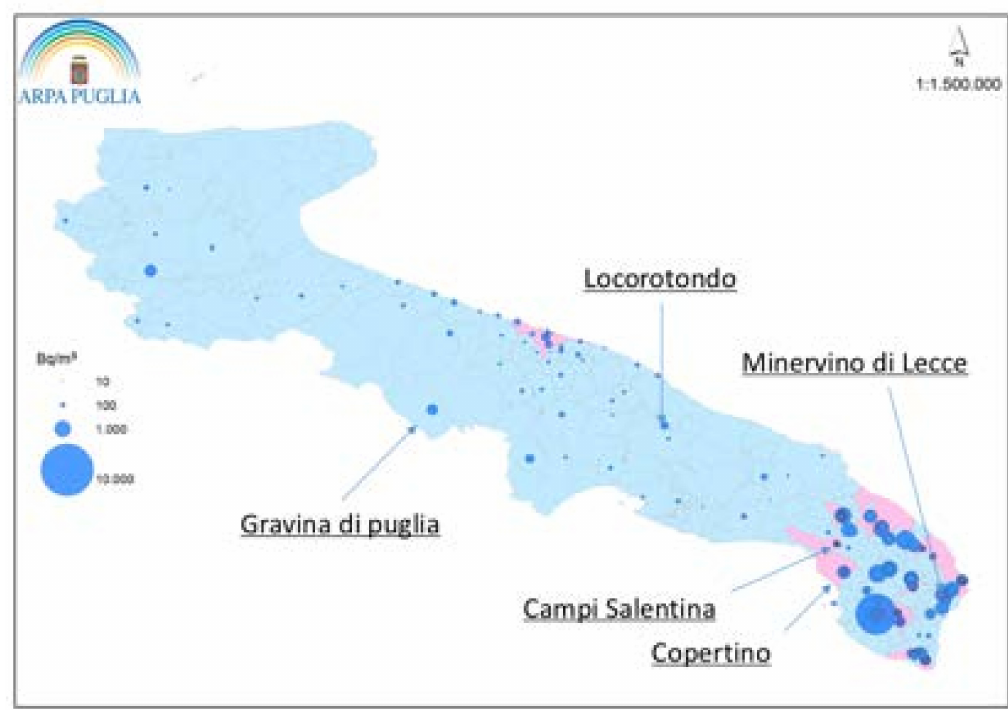
Figure 4. Annual Average concentration of Radon in Apulia region. Notes: In the map, blue circles represent the housing, schools, and workplaces in which ARPA Puglia made the measurements of the concentration of radon. The diameter of each circle is proportional to the average annual concentration measured. The municipalities for which data from at least seven in-house measurements are available and are highlighted in pink. This agency highlights on the basis of the experience gained in the field and especially of what was reported in the literature, that the only safe method to determine the concentration of radon gas inside a closed environment, independently of the results of the campaigns of previously measurements carried out in the same region, same province, the same municipality, even as an adjoining palace, is the direct measure. It was shown that adjacent buildings, with identical constructive characteristics, can have different radon concentrations. Therefore, to evaluate the concentration of radon in a closed environment, starting from experimental measurements carried out in other closed environments in other buildings that exist in the same area, municipality, or province (such as the data shown in the map) could lead to gross approximations for both defect and excess (Modified by ARPA publications,